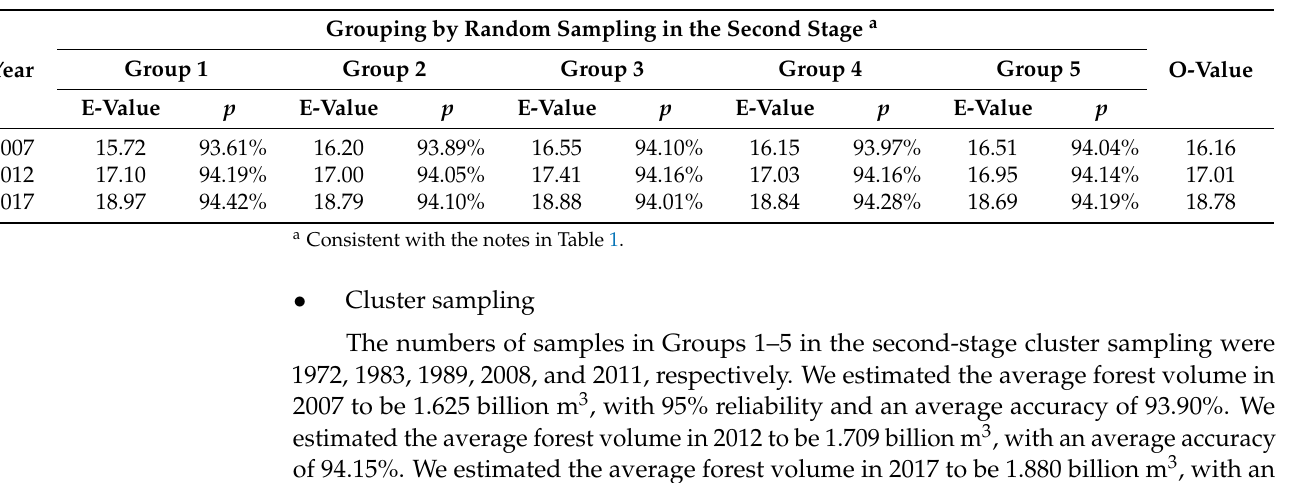
Table 3. Estimation results of forest volume by random sampling in second stage.